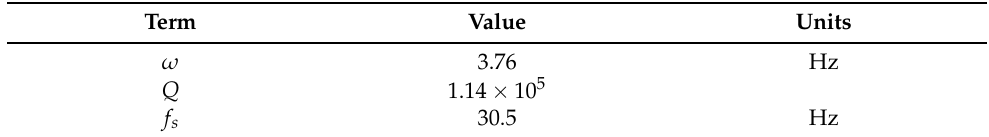
Table 1. Oscillator parameters for optomechanical inertial